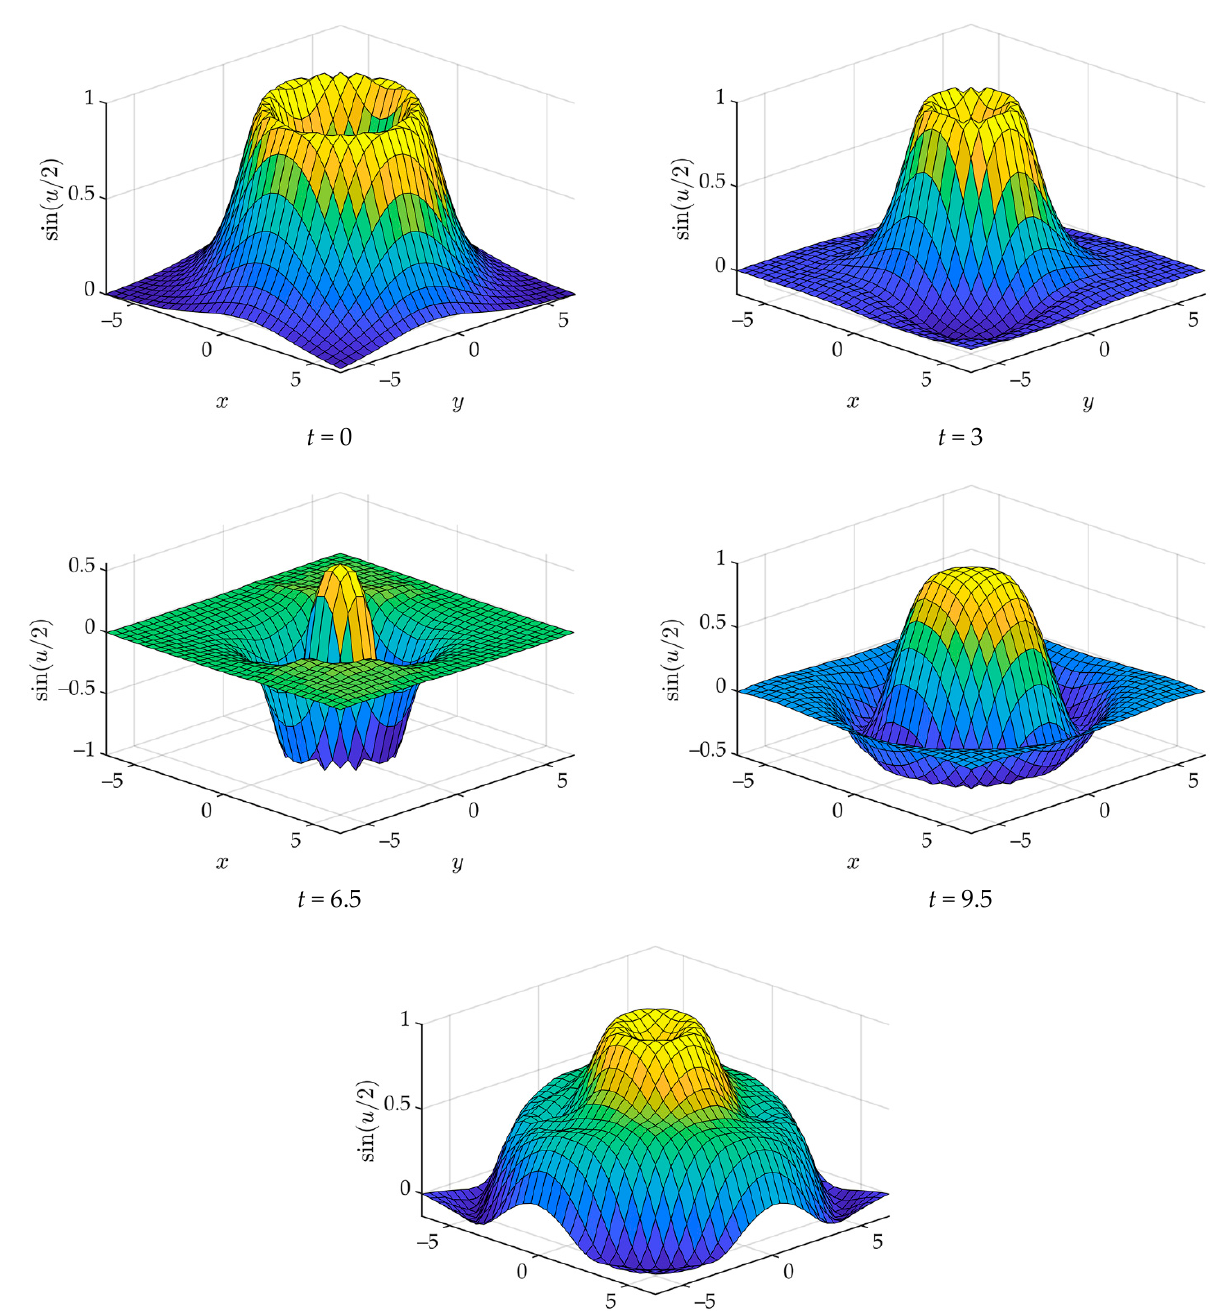
Figure 6. Evolution of the elliptical ring soliton arising in Case III of Example 3.